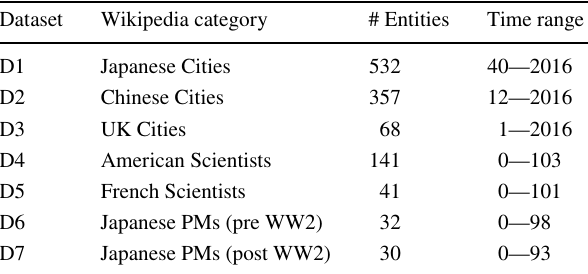
Table 2 Summary of datasets (the time ranges of datasets D 1 , D 2 , D 3 are based on absolute time, while those of datasets based on relative